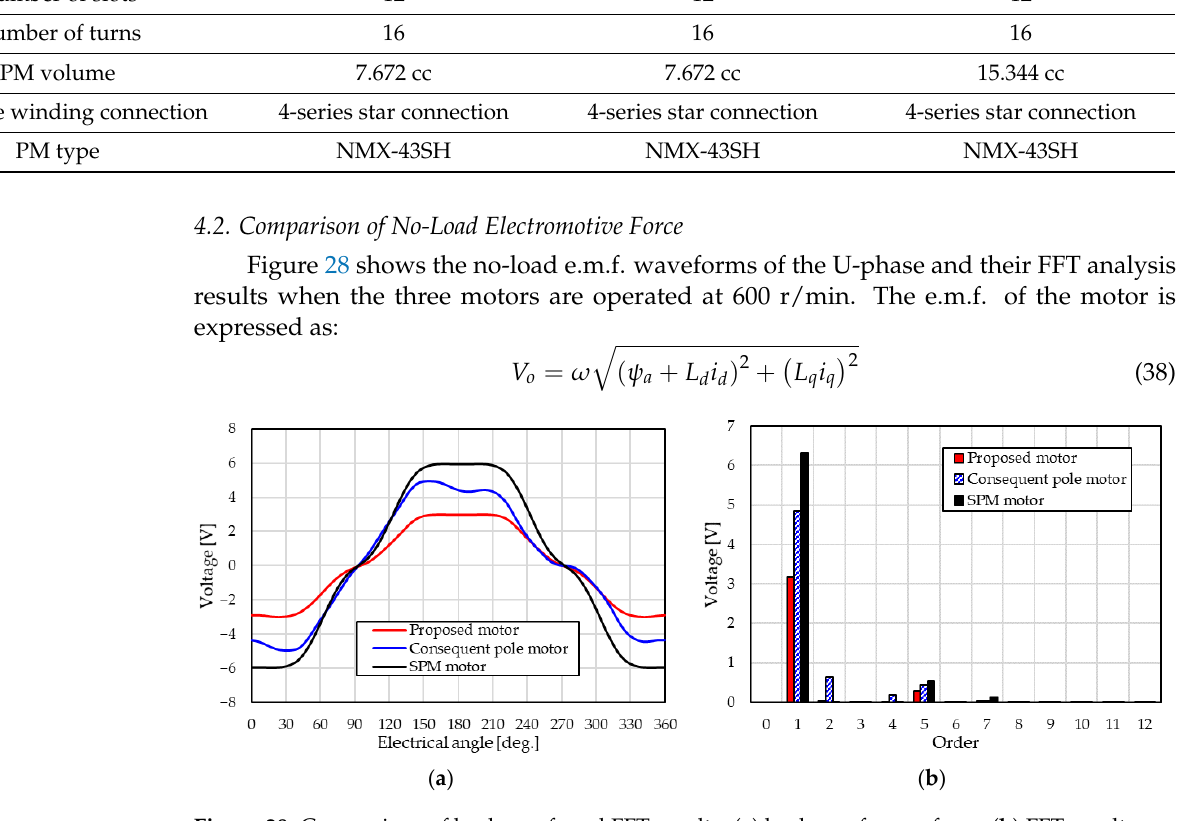
( b ) Figure 29. Comparison of inductance: ( a ) d-axis inductance; ( b ) q-axis inductance.